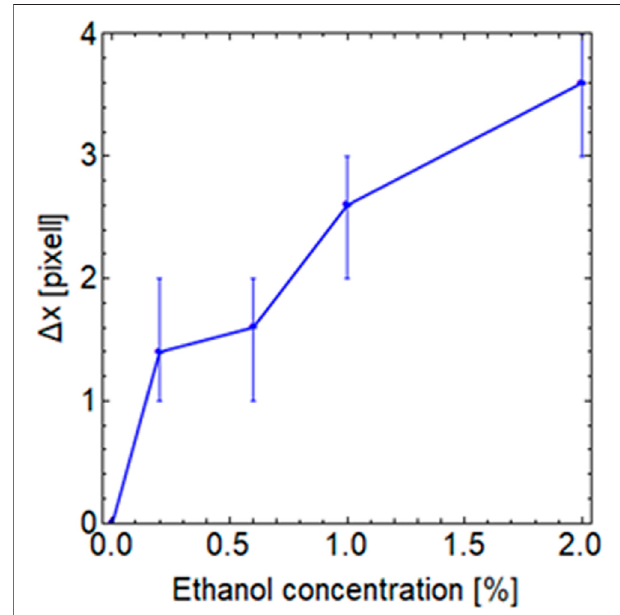
FIGURE 11 | The shift of the image Δ x owing to the change of the angle showing the minimum re fl ectivity as a function of the ethanol gas